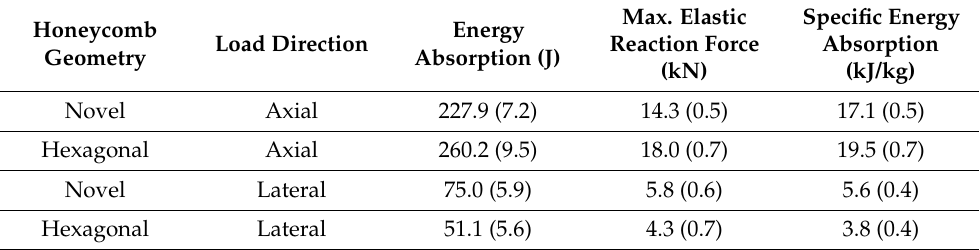
Table 3. Average values and standard deviations of the for energy absorption, maximum reaction force at the initial elastic peak, and energy absorption per unit mass, for the novel and hexagonal geometries in the regular scale under axial and lateral loads (from experimental